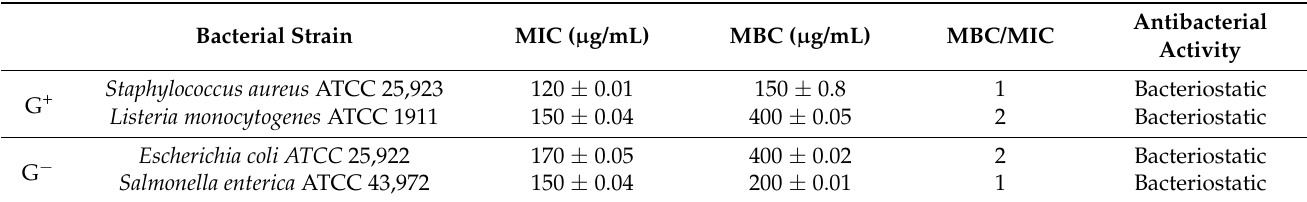
Table 3. Minimum Inhibitory Concentrations (MIC) and Minimum Bactericidal Concentrations (MBC) of Lm